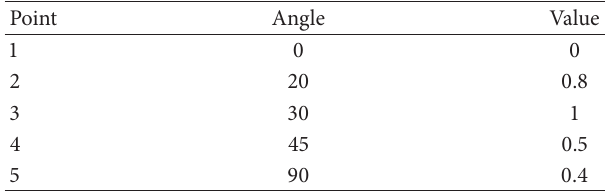
Table 2: Point values for impact angle function